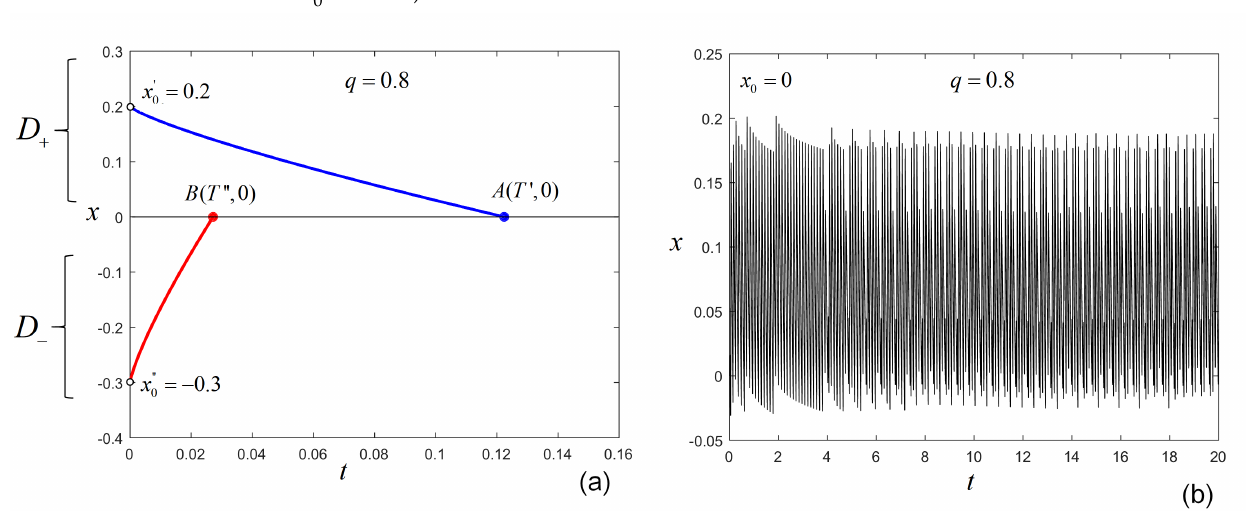
= 0.2 (blue) and x (cid:48)(cid:48) = − 0.3 (red). The solu- 0 0